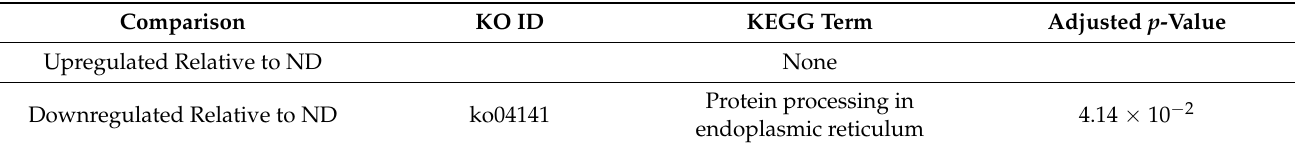
Table 7. Summary of the top five (when available) KEGG pathways involved in LD. The table shows pathways up- and downregulated relative to ND. Enriched KEGG pathways were identified with the GAGE and Pathview packages in R. Terms were sorted by the Benjamini-Hochberg adjusted p -value. Pathways differentially expressed relative to MD are shown in Table 5, and a complete list of up- and downregulated KEGG terms can be found in Supplementary Table